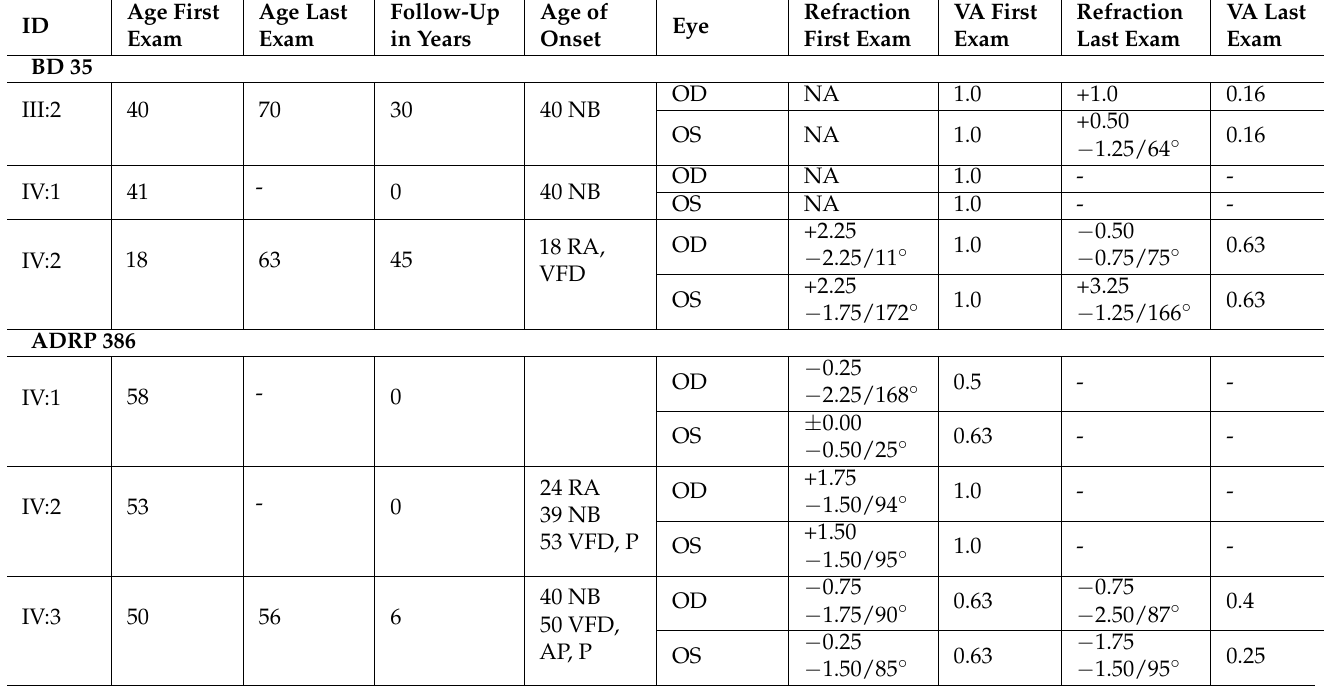
Figure 2. Pedigrees and genotypes of both families. I–IV: consecutive generations. Onset of disease with peripheral atrophic lesions was documented in patient IV:2 from family BD 35 at 18 years of age and in patient IV:2 from family ADRP 386 at 24 years of age (Table 1). Functional problems were noted later at about 40 years of age (patients III:2 and IV:1 from family BD35; patients IV:2 and IV:3 from family ADRP 386) with the onset of night blindness. In the same patients, subjective problems due to visual field defects were noted at about 50 years of age. Table 1. Patient data: examination, age of onset,